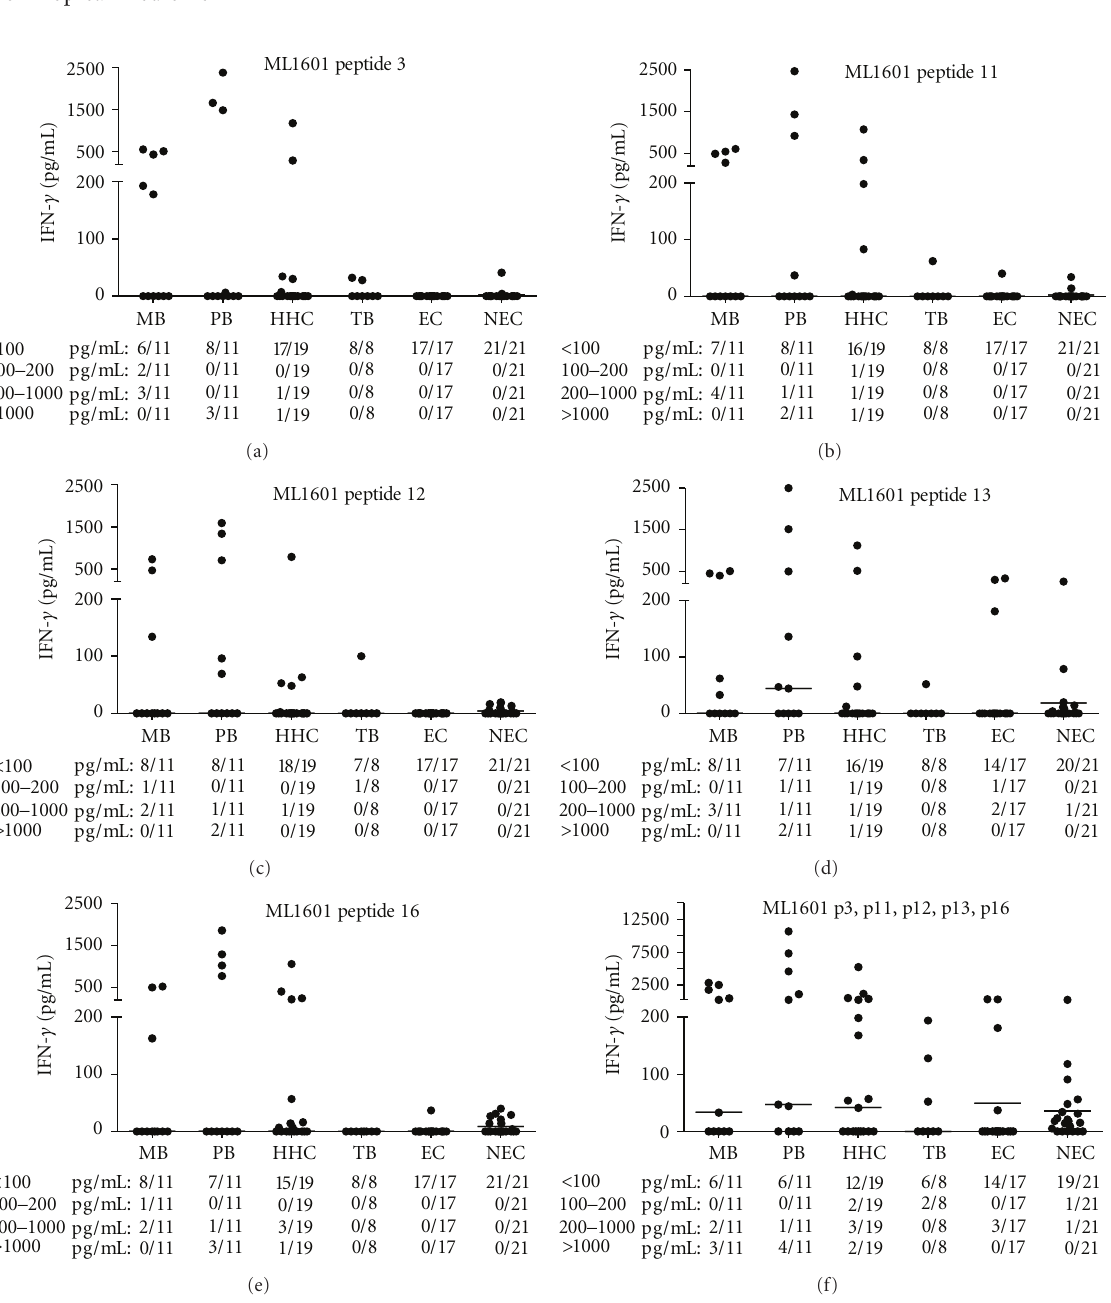
Figure 3: IFN- γ production by PBMC induced in all test groups by ML1601c peptides p3, p11, p12, p13, and p16 and the sum of the IFN- γ values for p3, p11, p12, p13, and p16 combined. The proportions of responders in each test group are indicated below the x